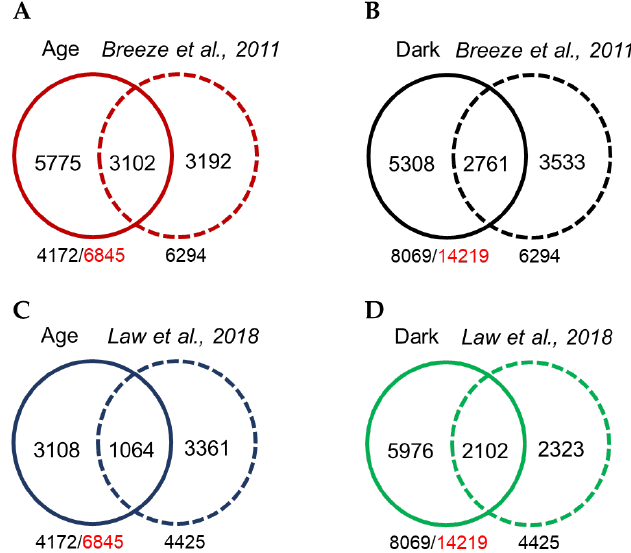
Figure 8. Comparison of M. truncatula and A. thaliana age-dependent and dark-induced transcriptomic profiles. ( A ) Comparison of M. truncatula age-dependent transcriptomic data with that of Arabidopsis thaliana reported by Breeze et al., 2011. ( B ) Comparison of M. truncatula dark-induced transcriptomic data with that of A. thaliana reported by Breeze et al., 2011. ( C ) Comparison of M. truncatula age-dependent transcriptomic data with A. thaliana dark-induced reported by Law et al., 2018. ( D ) Comparison of M. truncatula dark-induced transcriptomic data with A. thaliana dark-induced tran- scriptomic data reported by Law et al.,